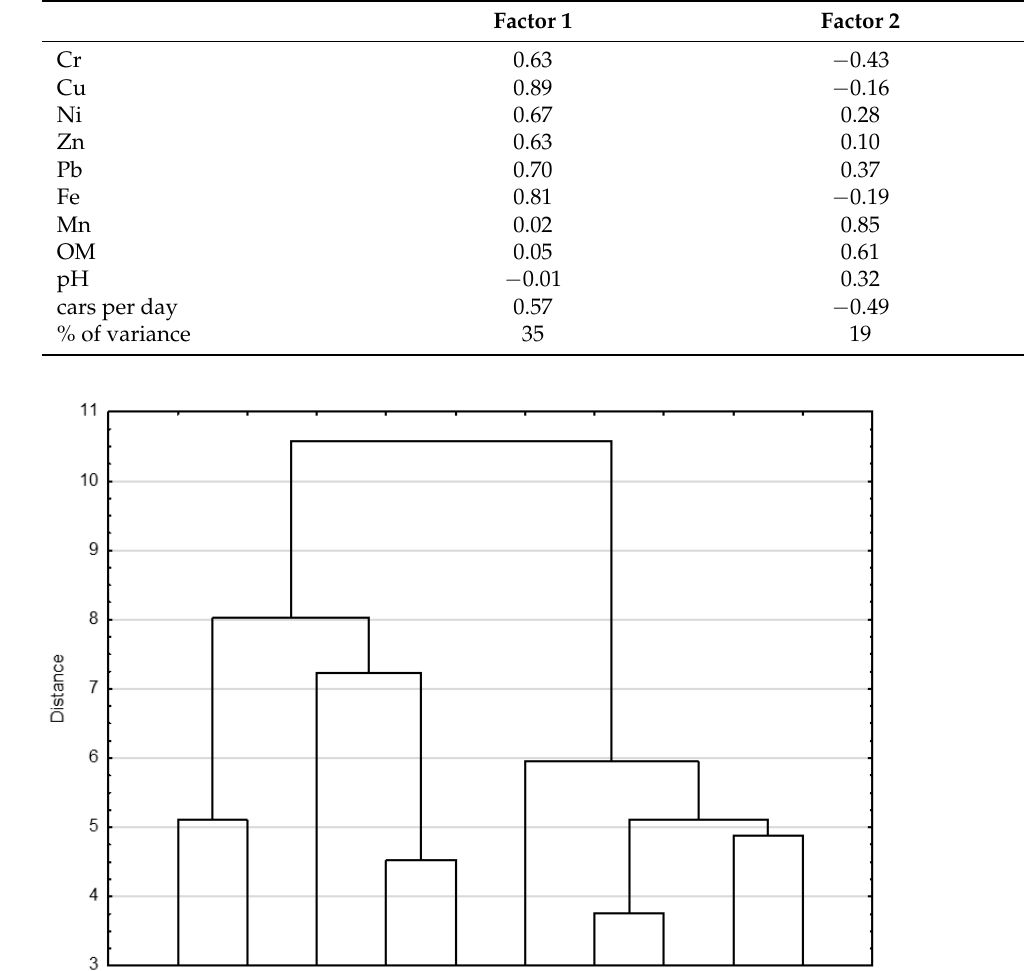
Table 4. The rotated component matrix for data of metals in street dusts of Suwalki (n = 25). Principal factors > 0.6 are selected in each column.